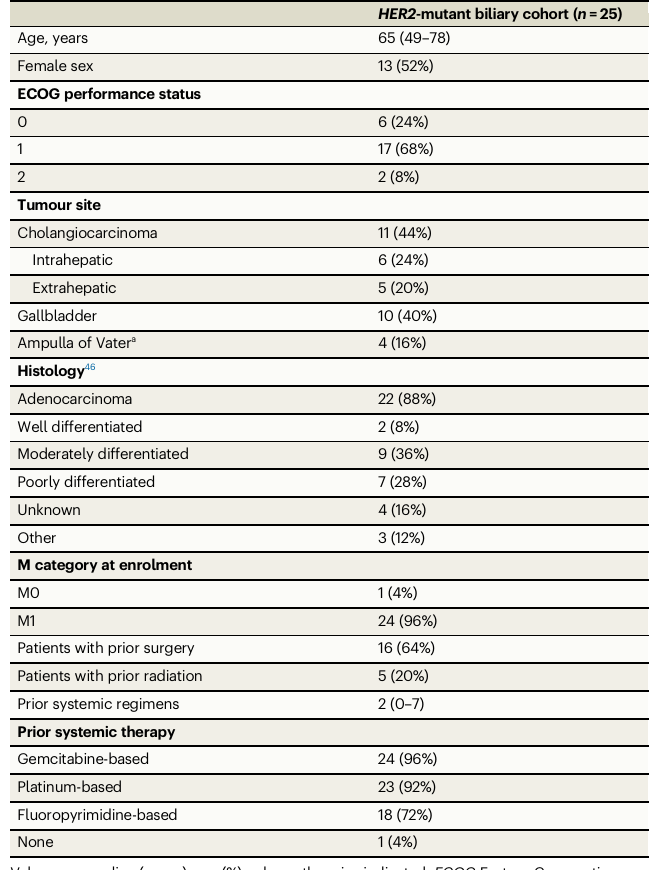
Table 1 | Baseline demographics and clinical